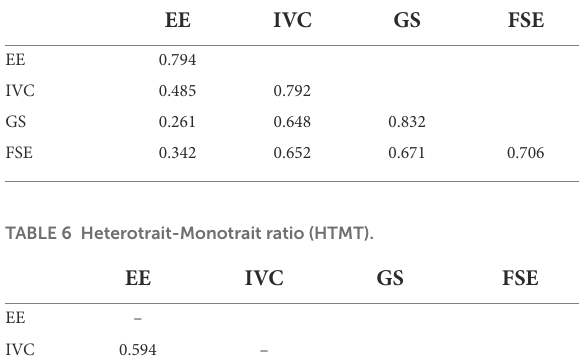
TABLE 5 Fornell and Larcker criteria.